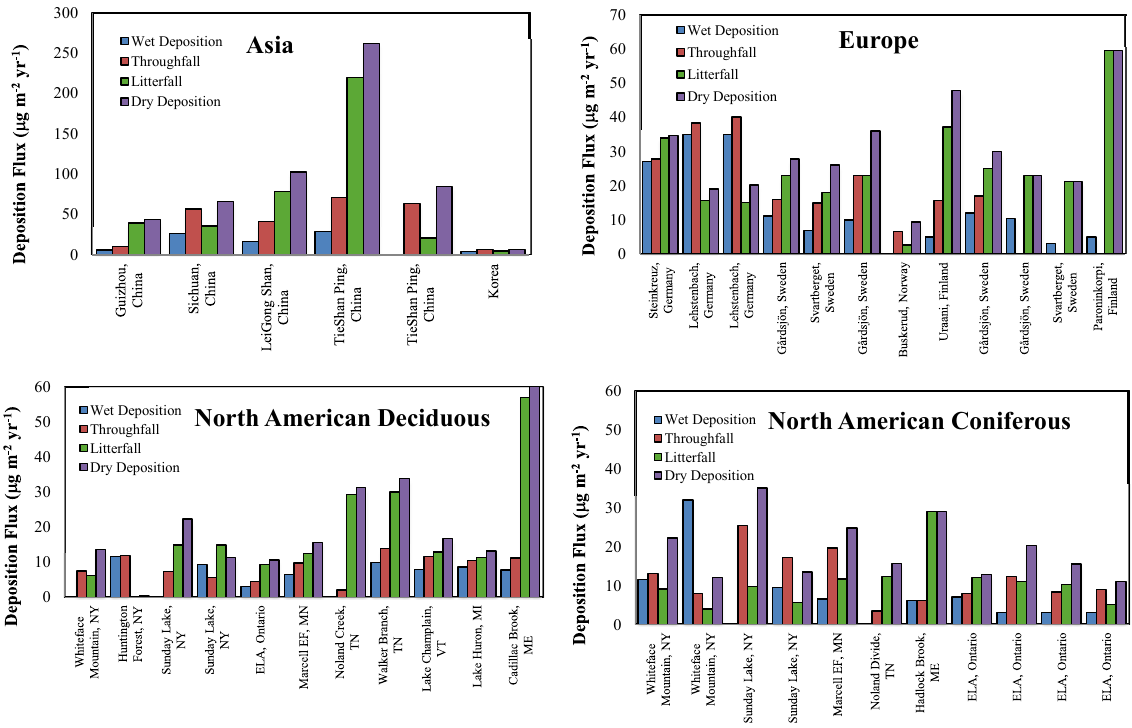
Figure 1. Contributions to the mercury deposition flux (µgm − 2 yr − 1 ) from wet deposition, throughfall Hg, litterfall Hg, and dry deposition in Asia, Europe, and North American deciduous forests and North American coniferous forests. References in order of appearance: Fu et al. (2010a, b); Wang et al. (2009); Luo et al. (2015); Schwesig and Matzner (2000, 2001); Hultberg et al. (1995); Lee et al. (2000); Larssen et al. (2008; Porvari and Verta, 2003; Iverfeldt, 1991; Lee et al. (1998); Blackwell and Driscoll (2015b); Choi et al. (2008); Demers et al. (2007); Kalicin et al. (2007); Graydon et al. (2008); Grigal et al. (2000); Fisher and Wolde (2012); Lindberg et al. (1996); Rea et al. (1996, 2001); Johnson et al. (2007); St. Louis et al.